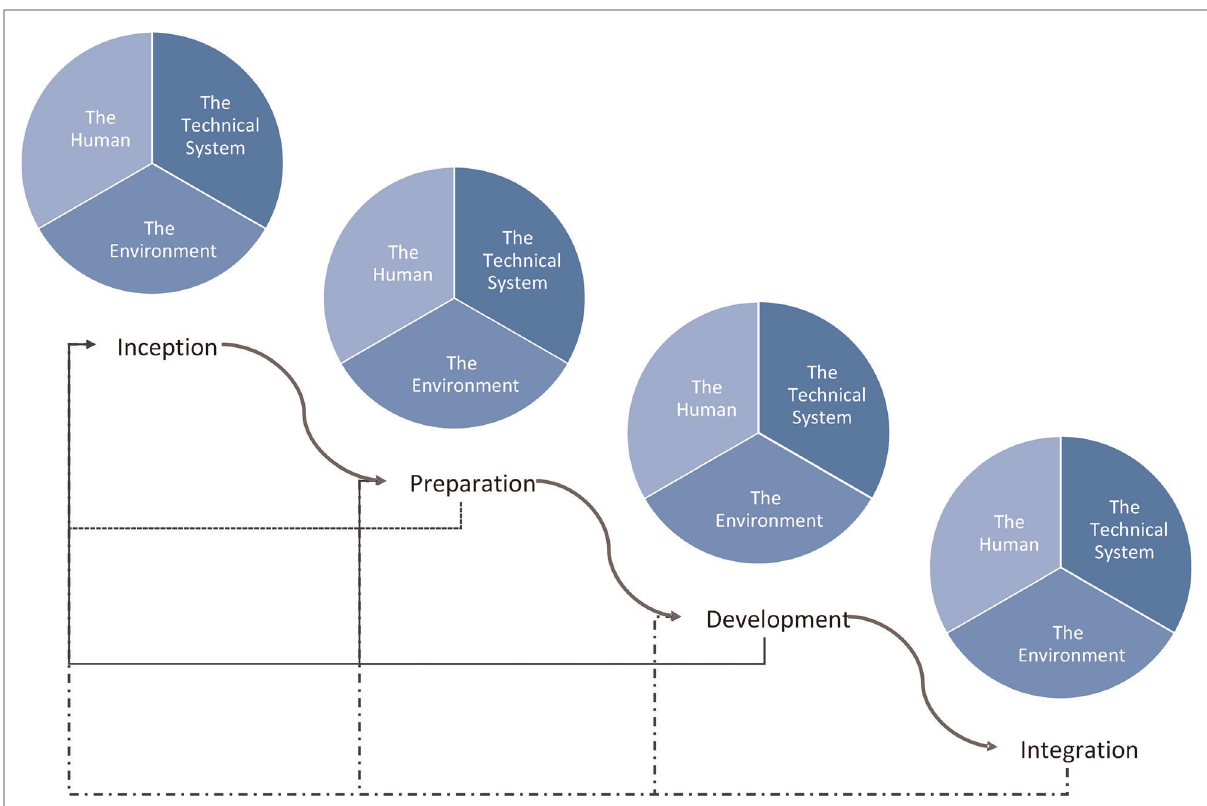
FIGURE 2 Proposed healthcare AI integration framework. Curved arrows show the progression through the integrated AI development process while the straight arrows show feedback from each phase into a previous phase. The framework begins in the top left with Inception and moves down and to the right, culminating in